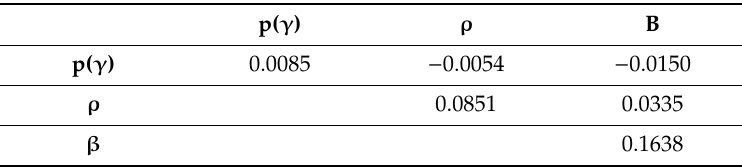
Table 2. Variance-covariance of